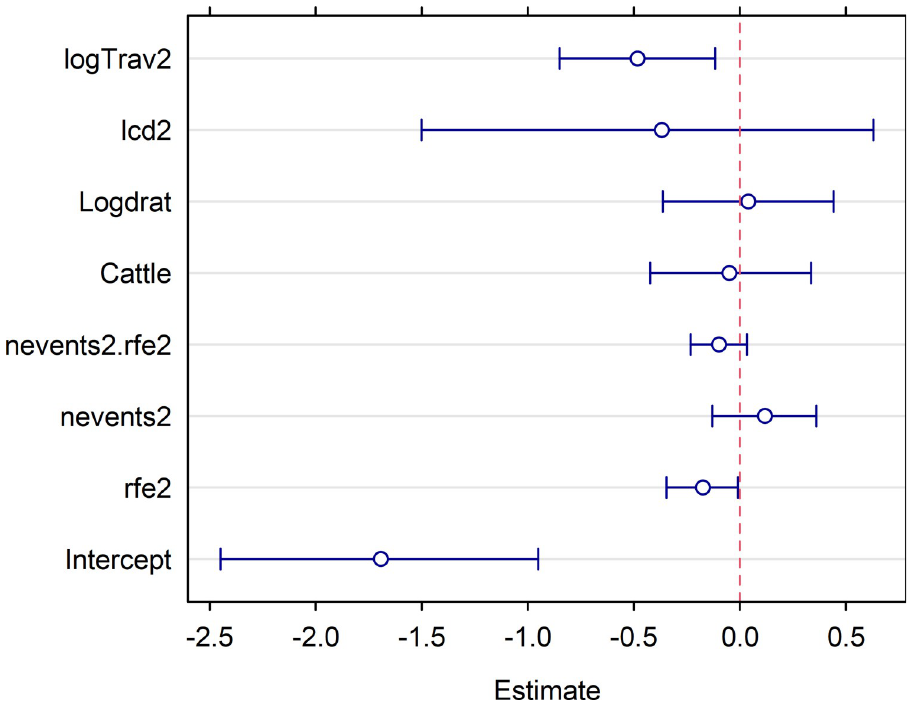
Fig 4. Posterior mean (circle) and 95% distribution interval (rod) of the predictor parameters for the DIC-best beta-binomial logistic regression model of RVFV seroprevalence in small ruminants after the 2013–2014 RVF outbreak in Senegal. The dashed, red vertical line shows the null hypothesis for the statistical test of these parameters ( α = 0.05): it was rejected when this line fell out of the 95% distribution interval. Labels for the parameters code: ‘rfe2’ cumulative rainfall, ‘nevents2’: number of dry spells during the rainy season 2014, ‘nevents2:ref2’ interaction between these two covariates, ‘Cattle’ cattle density, ‘logdrat’ log ratio of small ruminant to cattle densities, ‘lcd2’ distance to the nearest municipality centro ï d linked with southern Mauritania via ruminant incoming trade, ‘logTrav2’ log of travel time need to cross a one-km pixel.